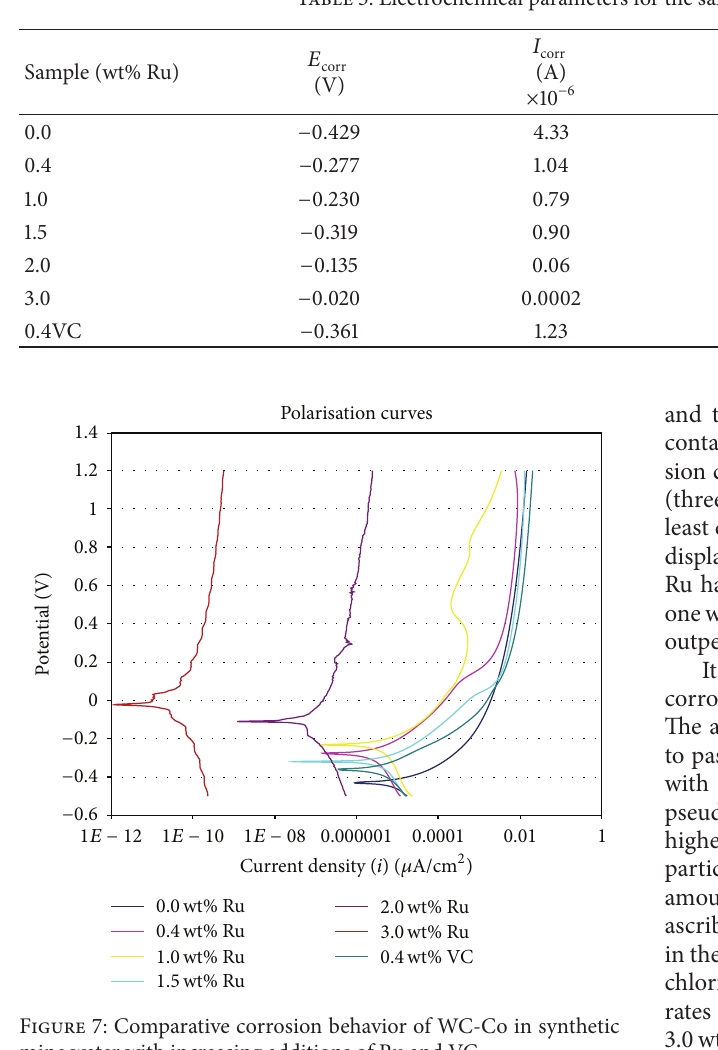
Table 5: Electrochemical parameters for the samples in synthetic mine water.